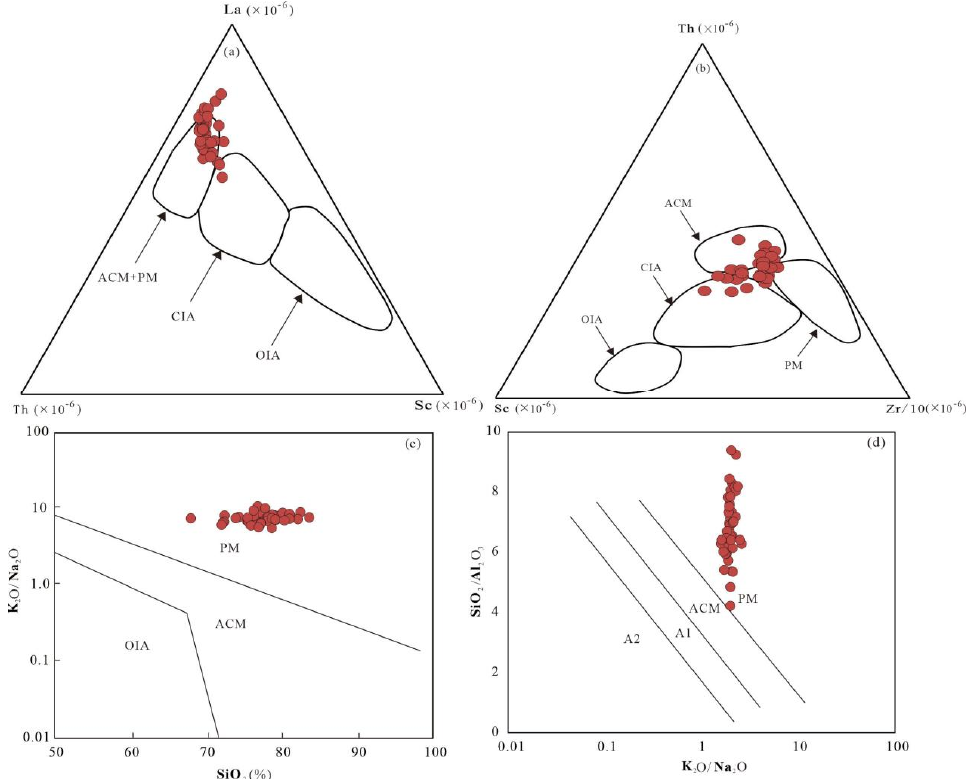
Figure 13. Discriminant map of provenance of sandstone Sifangtai Formation in the northern Songliao Basin: ( a ) La-Th-Sc and ( b ) Th-Sc-Zr/10 (after Xia et al. [6]) ( c ) K 2 O/Na 2 O-SiO 2 (after Roser and Korsch. [69]); ( d ) SiO 2 /Al 2 O 3 -K 2 O/Na 2 O (after Maynard et al. [70]).